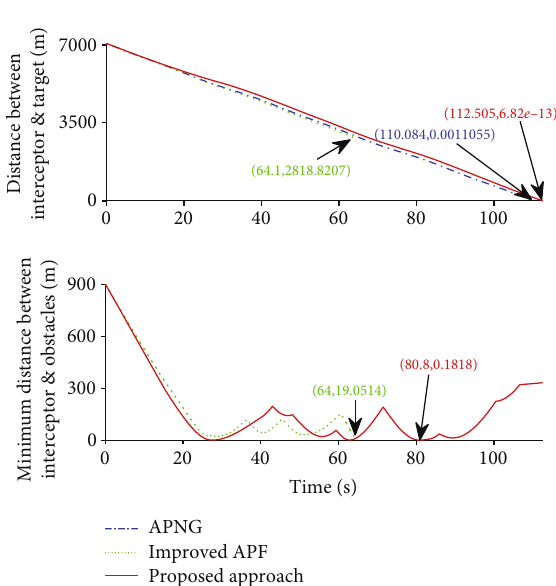
Figure 24: Flight trajectory projections of interceptor and target in case 5.